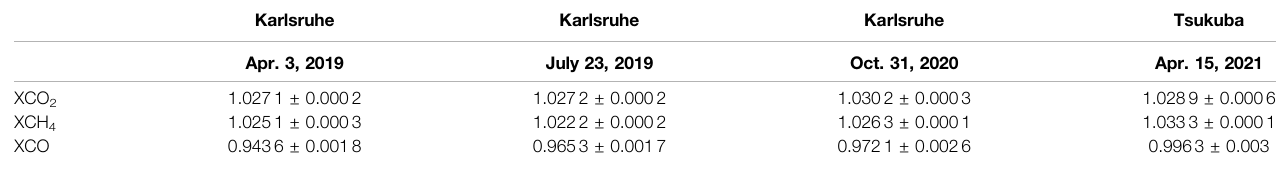
TABLE3| Calibrationfactorsderivedfromtheside-by-sidemeasurementsattheTCCONstationsKarlsruheandTsukubaoverthepastyears.Thecalibrationfactorsarethe average hourly ratios X gas, TCCON /X gas,EM27/SUN , the error bars are the standard deviations of the hourly ratios throughout the respective side-by-side deployment. Karlsruhe Karlsruhe